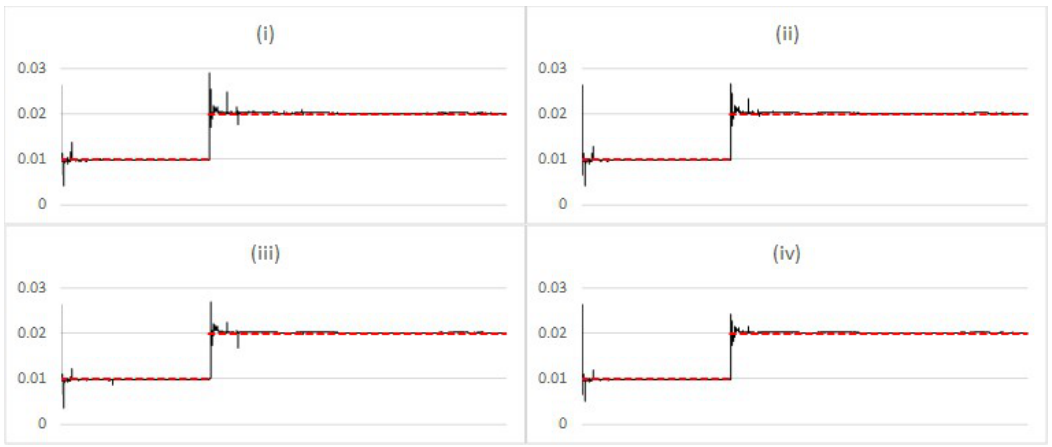
Figure 10. Comparing estimated posterior expected value (black) vs. simulation input value (red) of σ with regime change after 10,000 steps, using the Liu and West filter with learning for different values of κ ( i ) 0.01; ( ii ) 0.02; ( iii ) 0.03; ( iv )